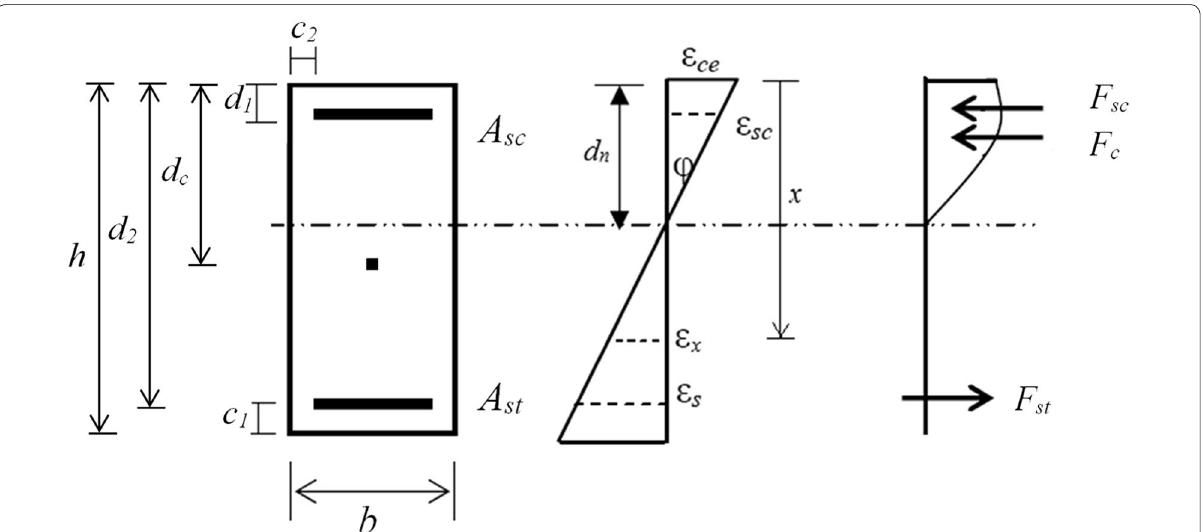
Fig. 1 Section, strain and stress diagram for moment–curvature